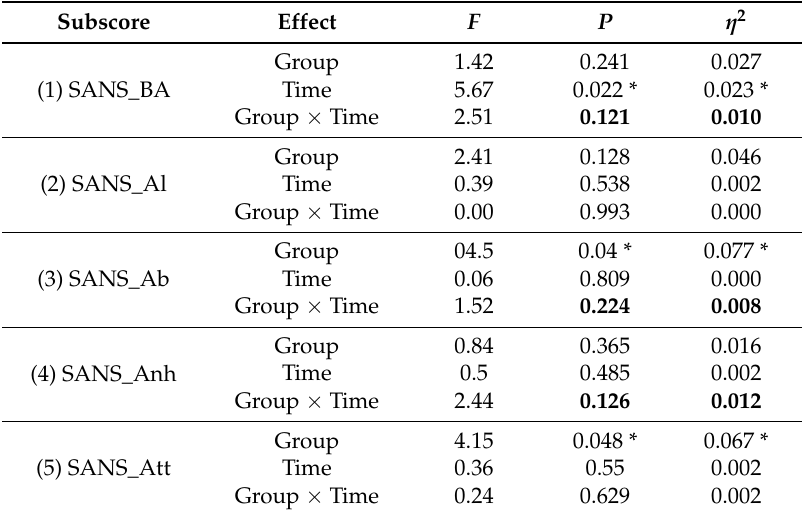
Table 4. Results of repeated measures ANOVAs for all SANS